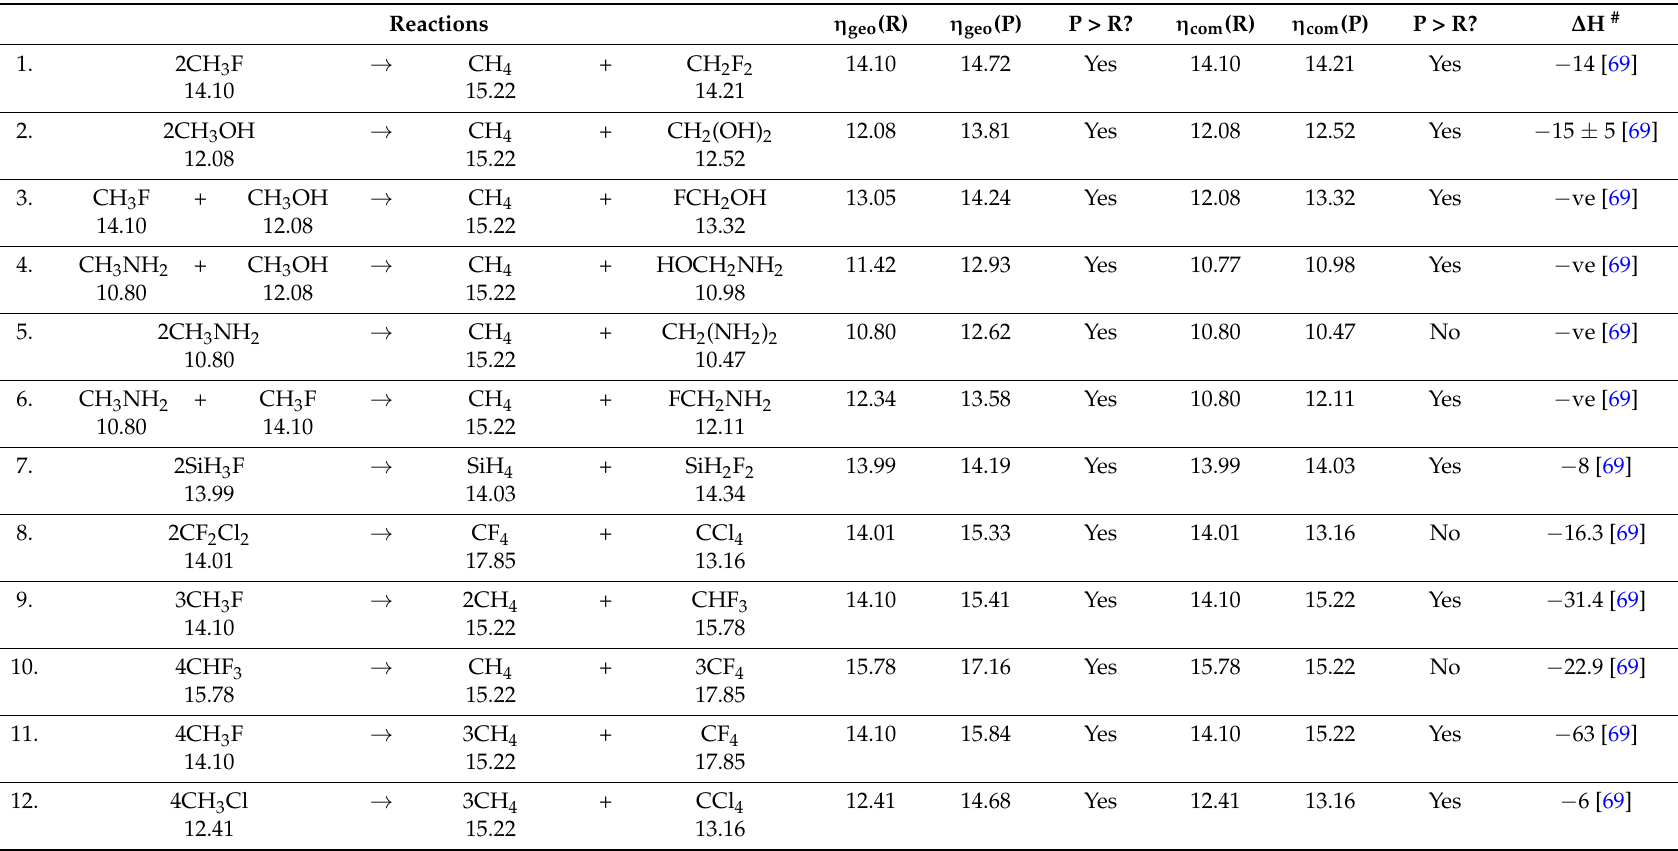
Table 2. Hardness ( η , eV) values of the individual reactants and products, geometric mean ( η geo , eV) of the hardness values and combined hardness values ( η com , eV) for the reactant and product sides at the LC-BLYP/6-311++G(2df,3pd)/def2-QZVP (def2-QZVP for iodine and Hg) level of theory for the chemical reactions. The enthalpy changes ( ∆ H) for the reactions are in